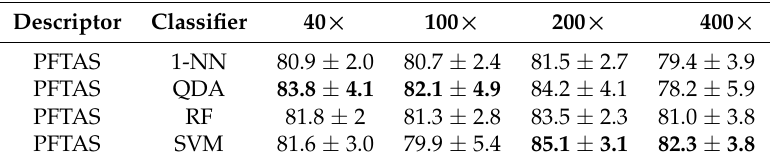
Table 10. Best average recognition rates (%) of the classifiers trained with different descriptors tested by Spanhol et al. [10] on BreaKHis dataset. Bold values indicate the highest recognition rate in each